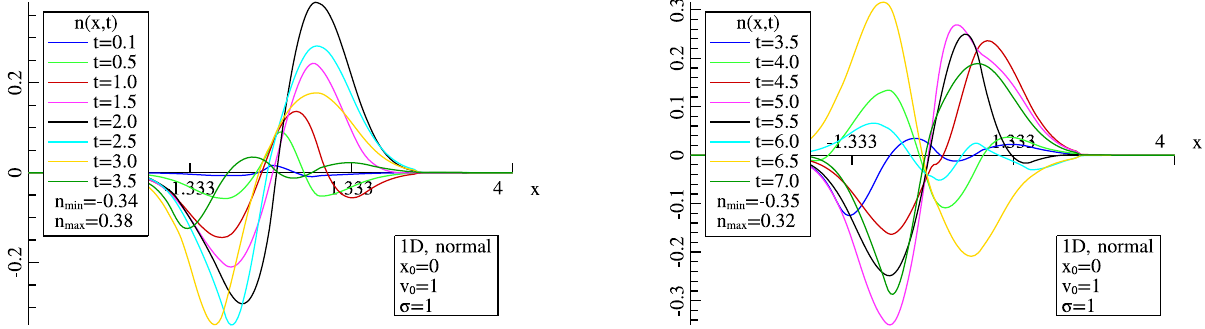
FIG. 5. Dynamics of the density n ð ~ x ; t Þ for the 1D plasma with the normal spatial and velocity distributions and for a charge starting moving from x 0 ¼ 0